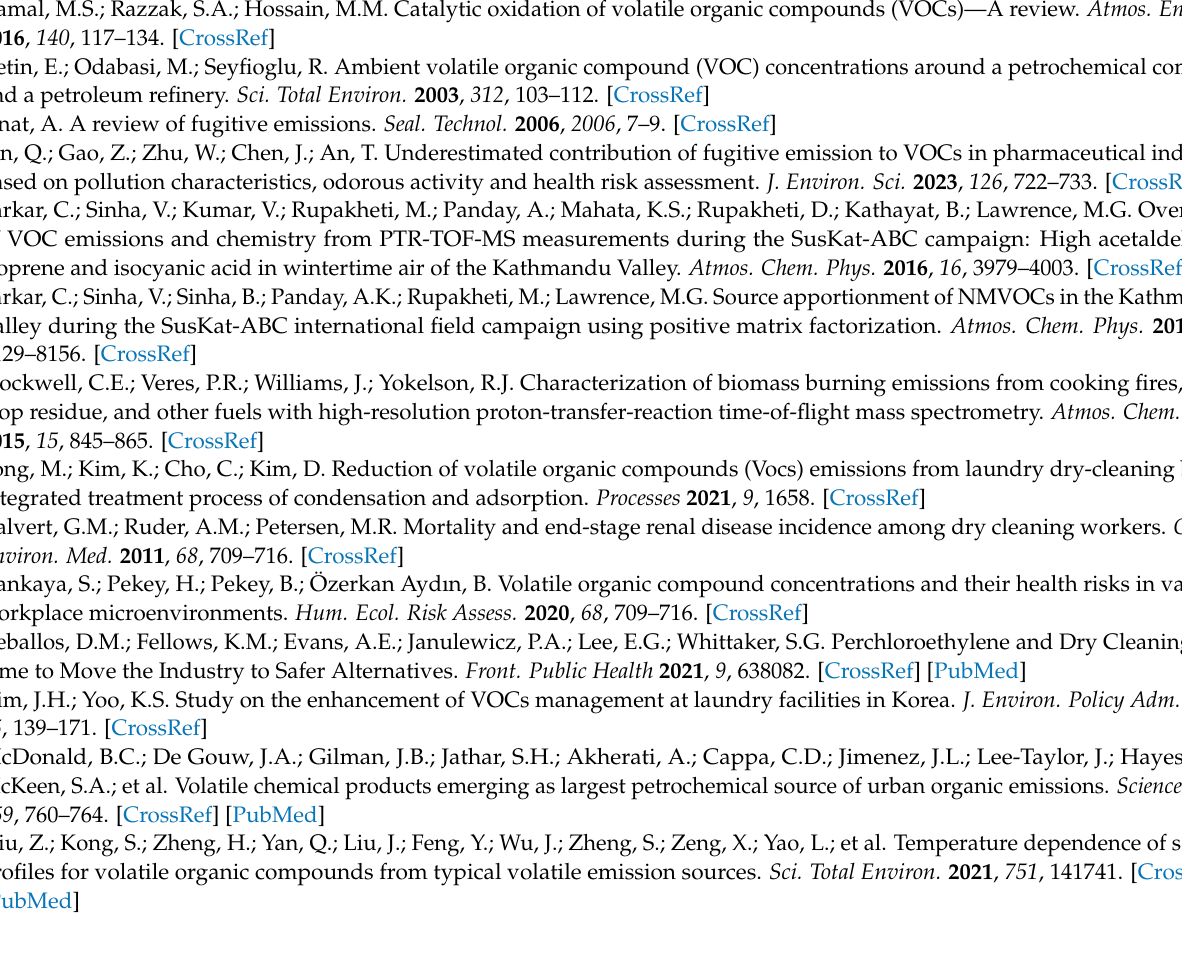
cycle of dry cleaning